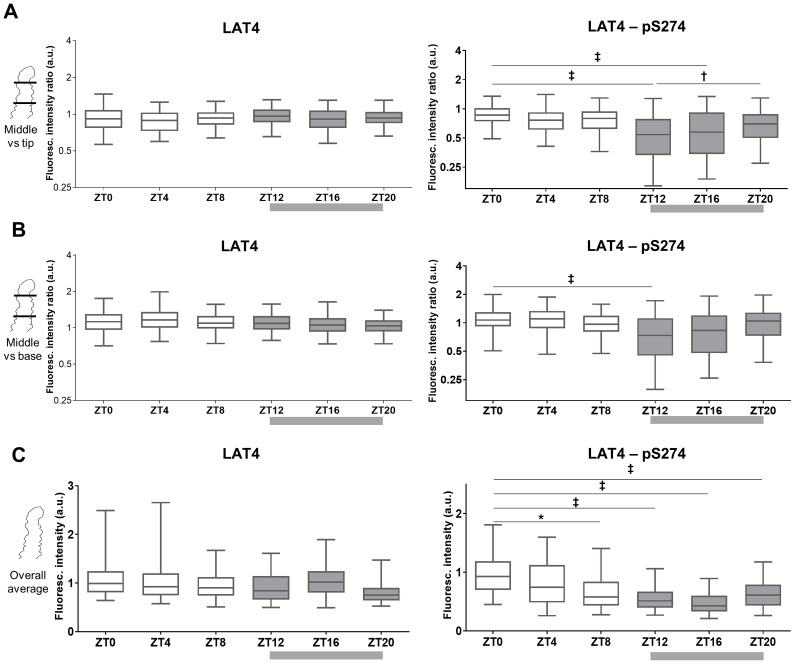
S274 phosphorylation in jejunum is decreased mostly at the middle part of the villus.A: Fluorescence ratio between the middle part and tip of jejunal villi. Logarithmic scale used. 1: same fluorescence intensity on middle part and tip, >1: fluorescence intensity is increased at the middle part, <1: intensity lower at middle part. B: Fluorescence ratio between the middle part and the base of jejunal villi. C: Quantitation of fluorescence intensity of jejunal villi. A to C: villi were stained with antibodies against LAT4 (left panels) or pS274 (right panels), and membrane marker E-cadherin. Fluorescence intensity determined with ImageJ 1x software and related to intensity of E-cadherin. Box at 25th and 75th percentile, line at median and whiskers at 5th to 95th percentile, n = 250–300 villi from 10–11 mice per time point from two separate experiments. Statistical analysis: One-way ANOVA using Tukey’s multiple comparison test, *p<0.05; †p<0.01; ‡p<0.001.